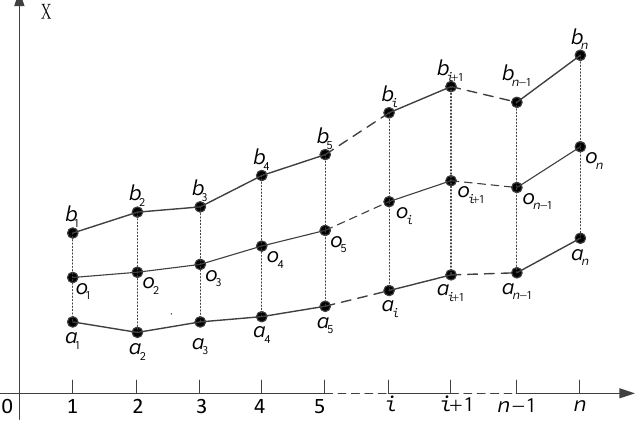
Figure 5. The health indicator sequence layer and its portable value.